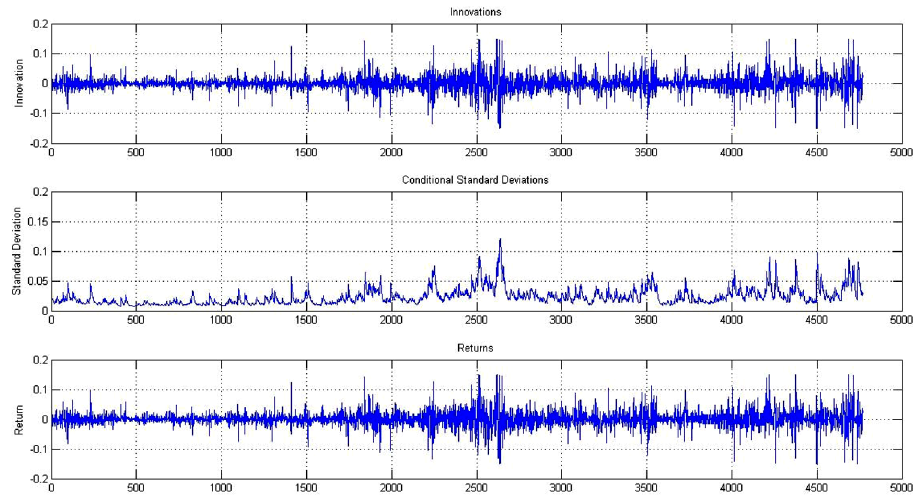
Figure 13. Innovations, Conditional standard deviation and Return charts (source: own processing based on the close prices SIF1 between 1/1/2000÷5/13/2019, on BSE. Results obtained in